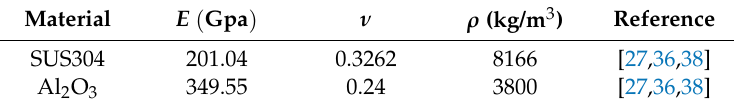
Table 1 . Material properties of metal ( SUS304 ) and ceramic ( Al (cid:2870) O (cid:2871) ). Table 1. Material properties of metal (SUS304) and ceramic (Al 2 O 3 ).